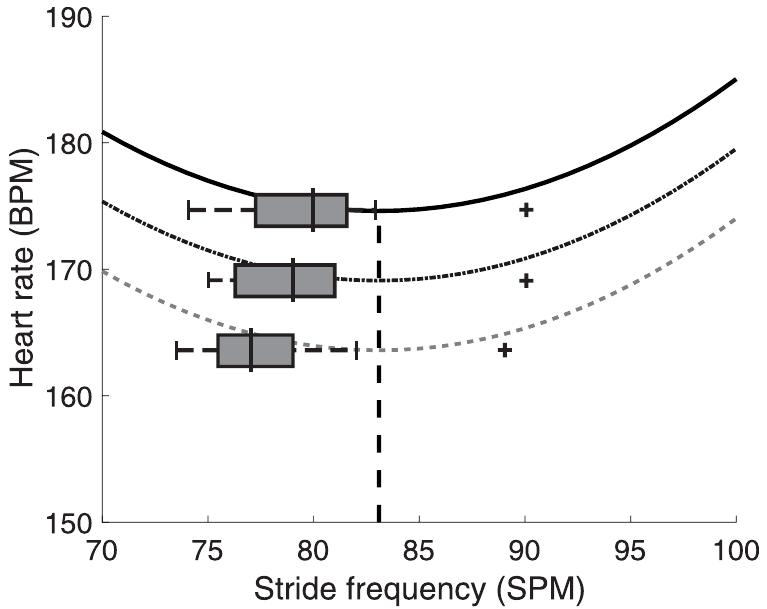
Fig 2. The relation between SF and HR for each speed series based on Model 1. From bottom to top V 90% , V 100% , V 110% . The central line in the boxplotrepresents the median,the edgesof the box are the 25th and 75th percentiles,and the whiskers extend to ± 1.5 of the interquartile range. The outliers(+) beyondthis range belongto a singleparticipant. An optimumof 83 strides (cid:1) min -1 was calculatedusing the parameters of Model